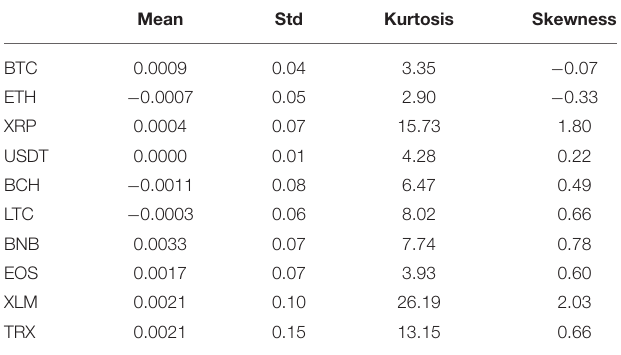
TABLE 1 | Summary statistics.